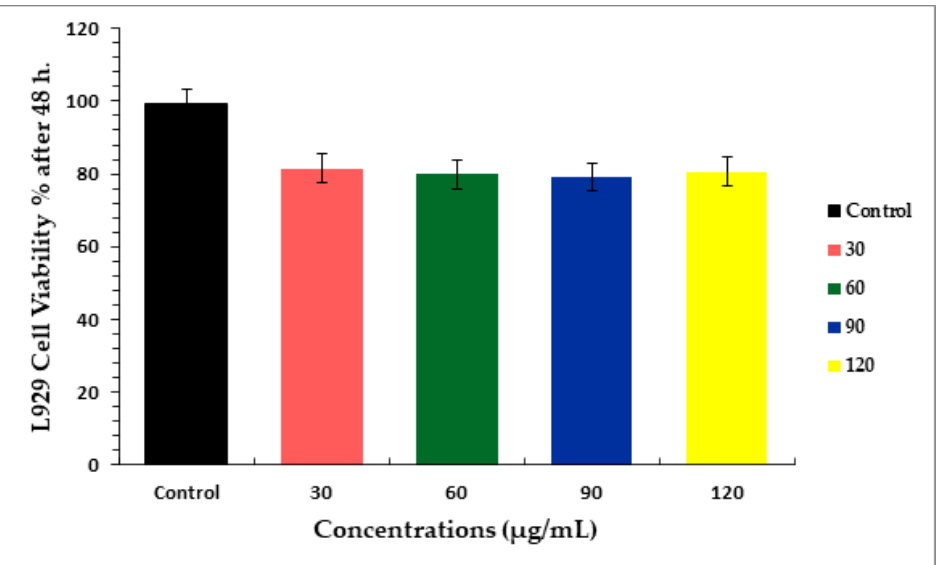
Figure 6. The MTT assay results of green-synthesized ZnO NPs on L929 normal fibroblast cell culture after 48 h. Cells were treated in a dose-dependent approach. The viability of the cells was evaluated using the MTT test, as detailed in the materials and methods section. Data displayed are mean ± standard deviation of three identical experimental tests done in triplicate.